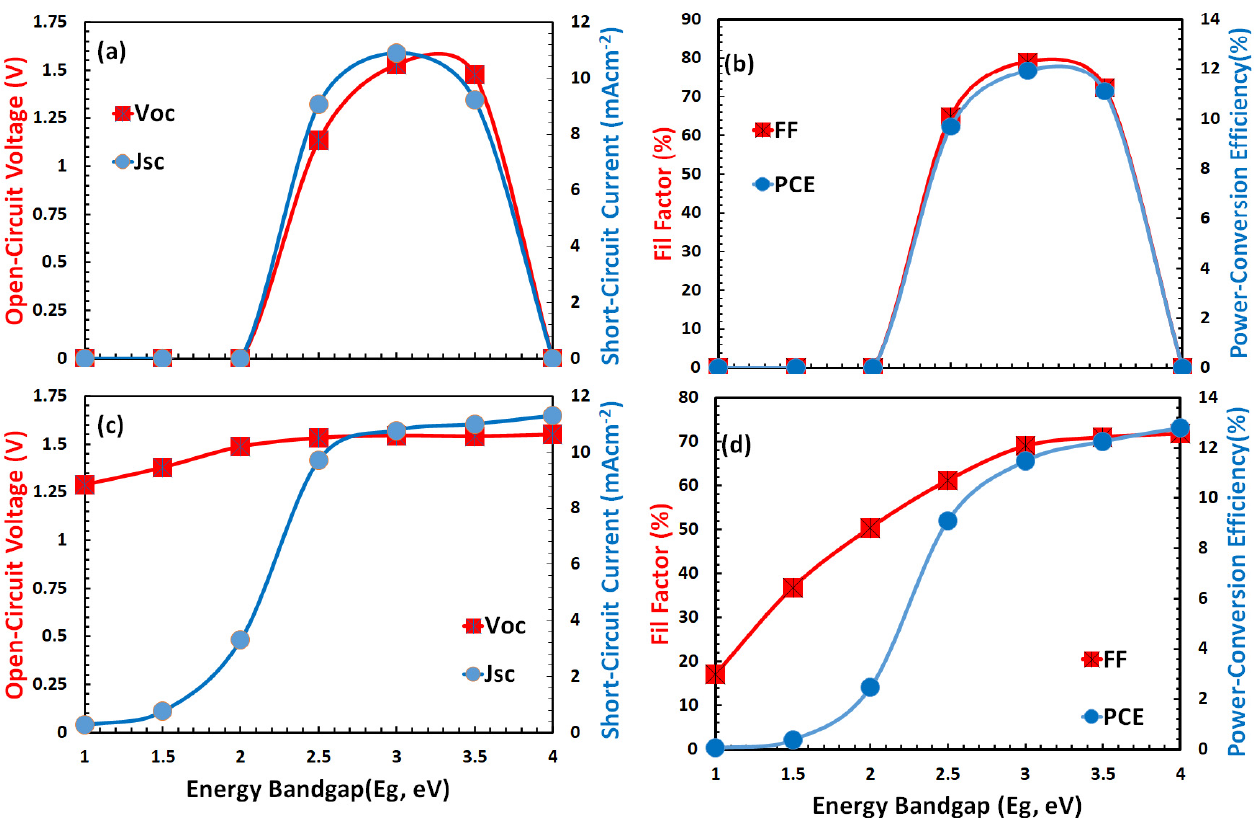
Figure 4. ( a ) Open-circuit voltage, short-circuit current, ( b ) fill factor, and power conversion efficiency of HTL as a function of electron affinity. ( c ) Open-circuit voltage, short-circuit current, ( d ) fill factor, and power conversion efficiency of ETL as a function of energy bandgap for Cs 2 TiBr 6 -based solar cell.